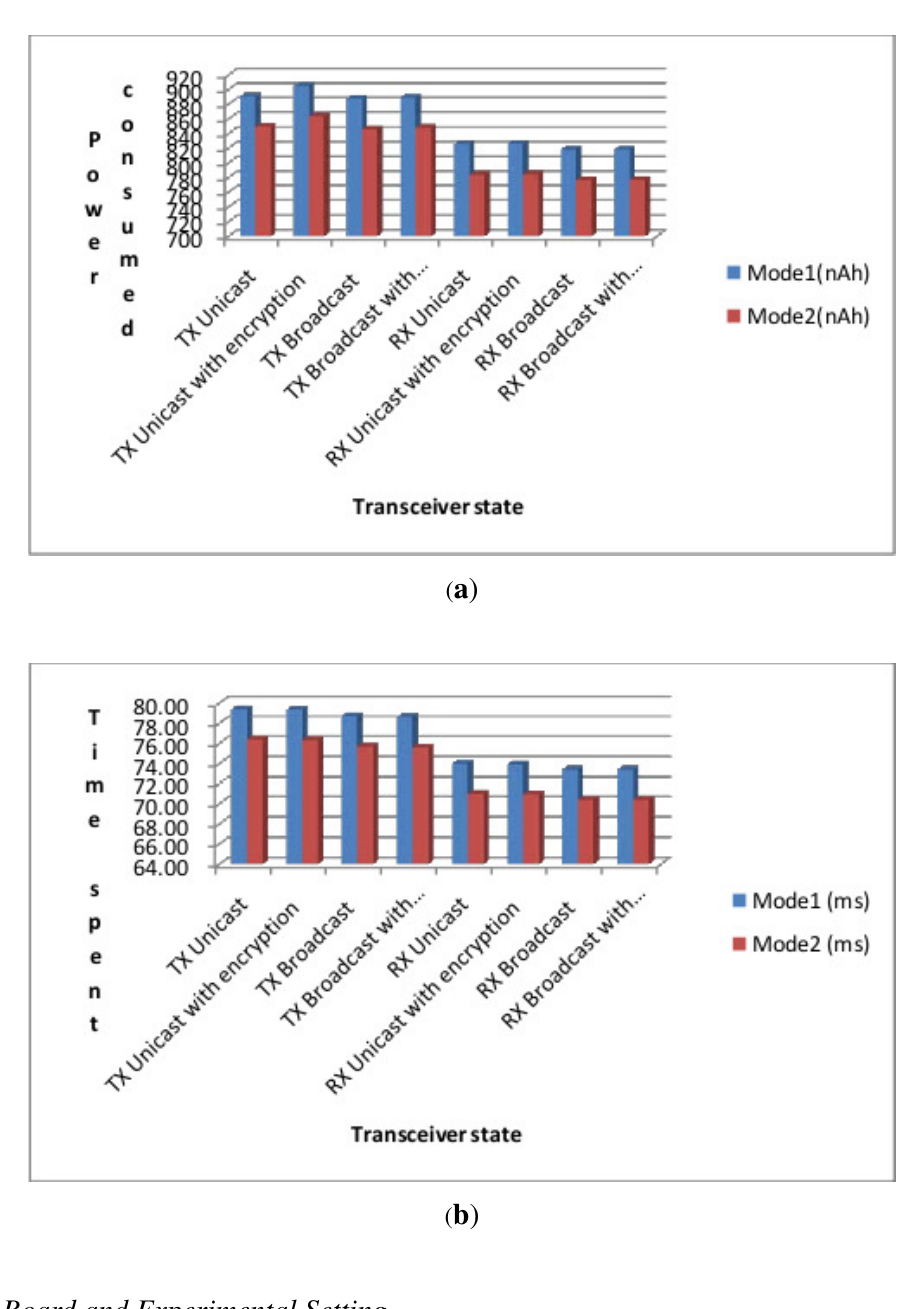
Figure 7. Waspmote Power and Time under Encryption. ( a ) Energy consumed in a mode (in nAh); ( b ) Time spent in a mode (in